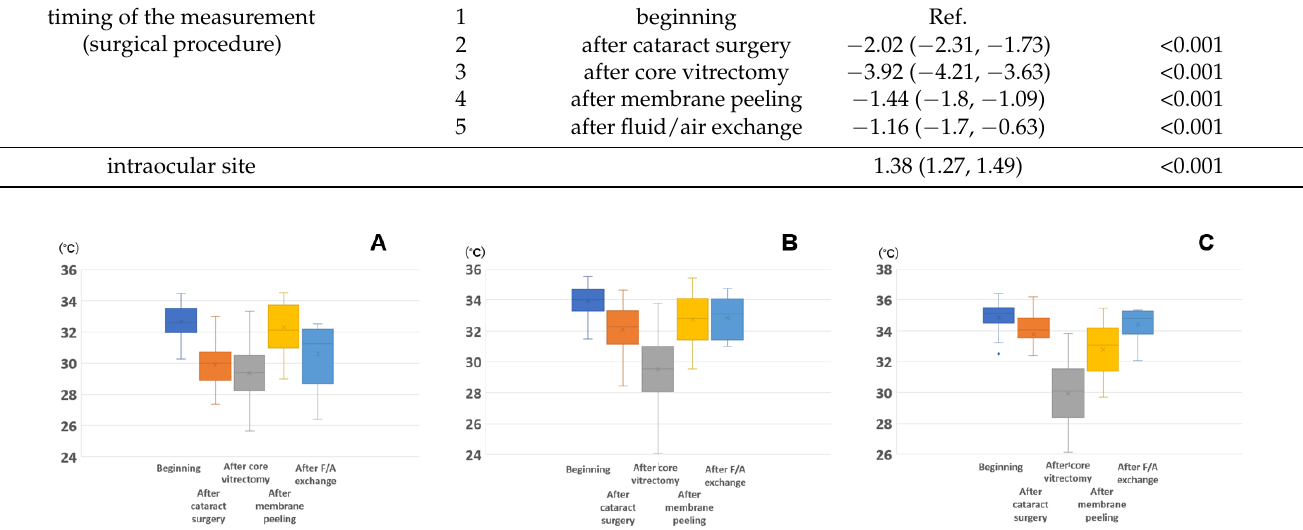
Figure 3. Intraocular temperature changes at a specific site during vitrectomy: ( A ) just posterior to the intraocular lens (BL), ( B ) mid-vitreous (MV), and ( C ) just anterior to the optic disc (OD). ( A ) The temperature at the BL is lower after cataract surgery and was stable after core vitrectomy and higher after membrane peeling. ( B ) The temperature at the MV is lower after cataract surgery and further lower after core vitrectomy and higher after membrane peeling and was stable after F/A exchange. ( C ) The temperature at the OD is lower after cataract surgery and is stable after core vitrectomy and higher after membrane peeling and tended to further increase after F/A exchange. Number of eyes: beginning ( n = 48), after cataract surgery ( n = 46), after core vitrectomy ( n = 41), after membrane peeling ( n = 36), after F/A exchange ( n = 10). The upper end of the whisker is the maximum value, whereas the lower end is the minimum value; the box indicates the interquartile range; the line in the box indicates the median value, and the × indicates the mean. F/A, fluid/air exchange. *: p < 0.05.